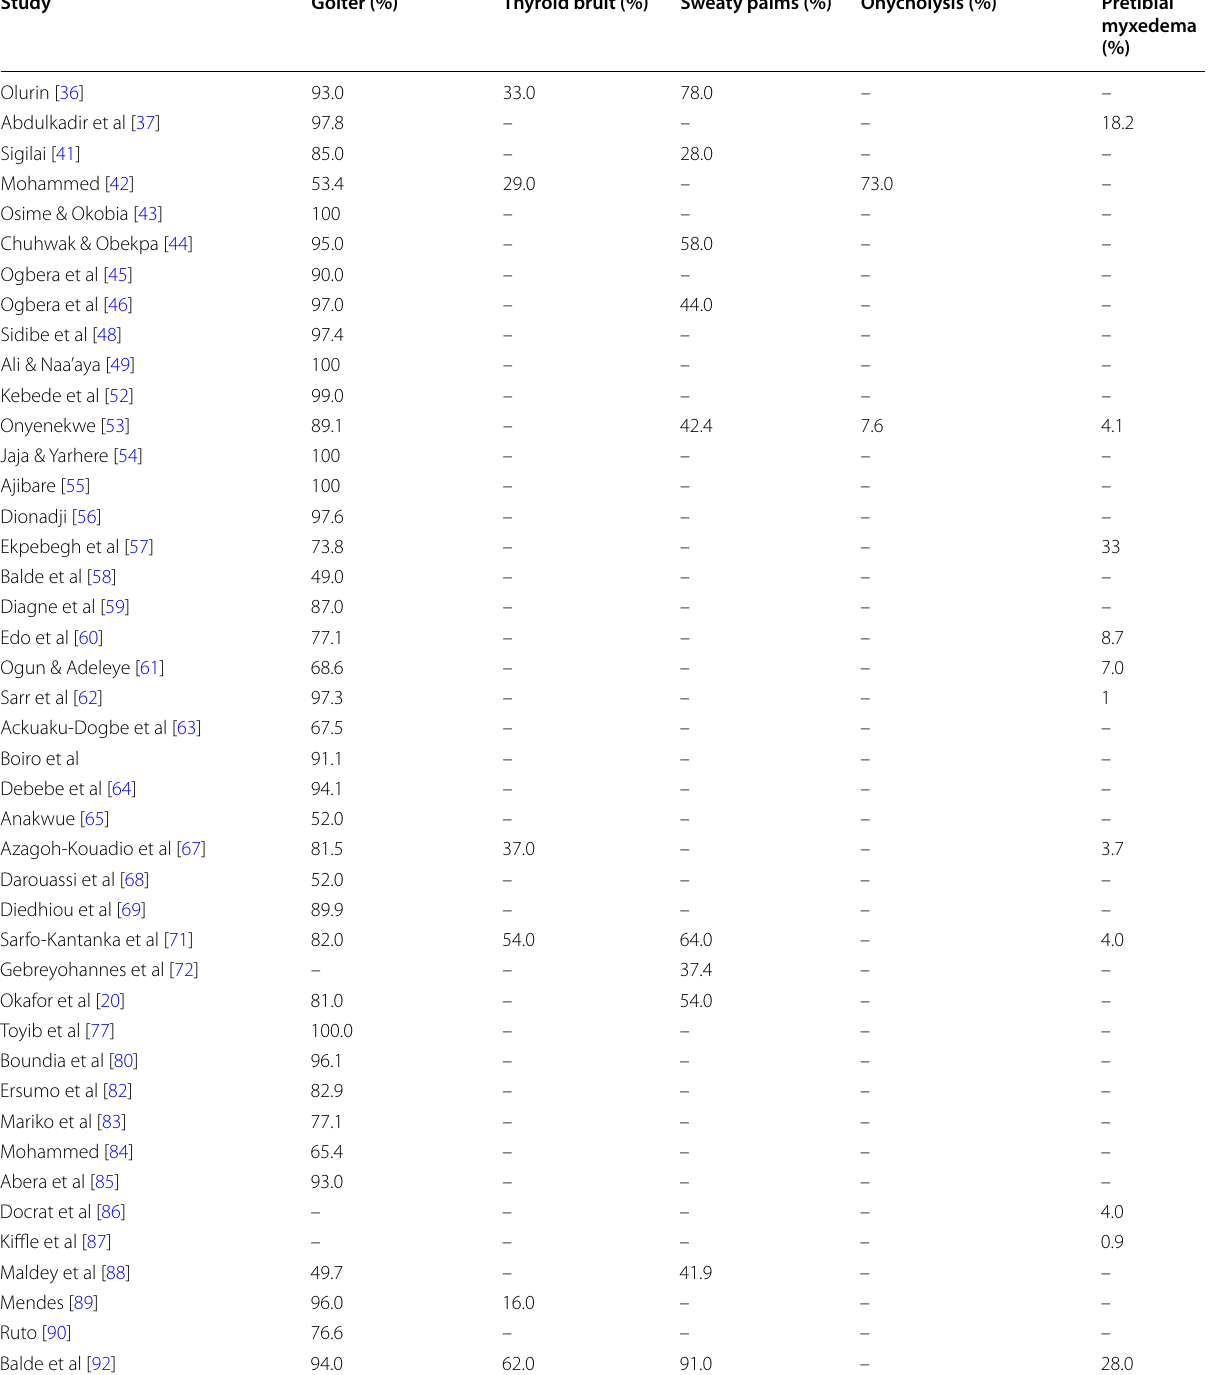
Table 7 General signs of